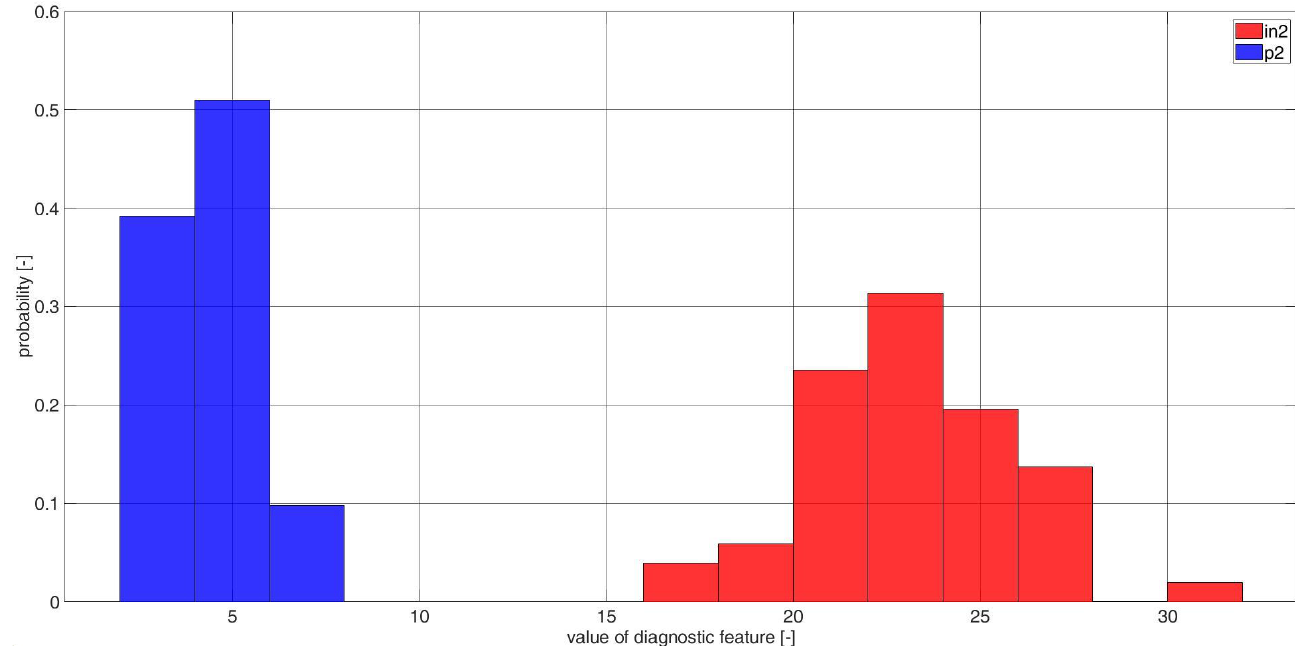
Figure A11. Histograms of diagnostic features based on the CCSM3 (correlation number is 10—Table A1) bearings in1 and p1.